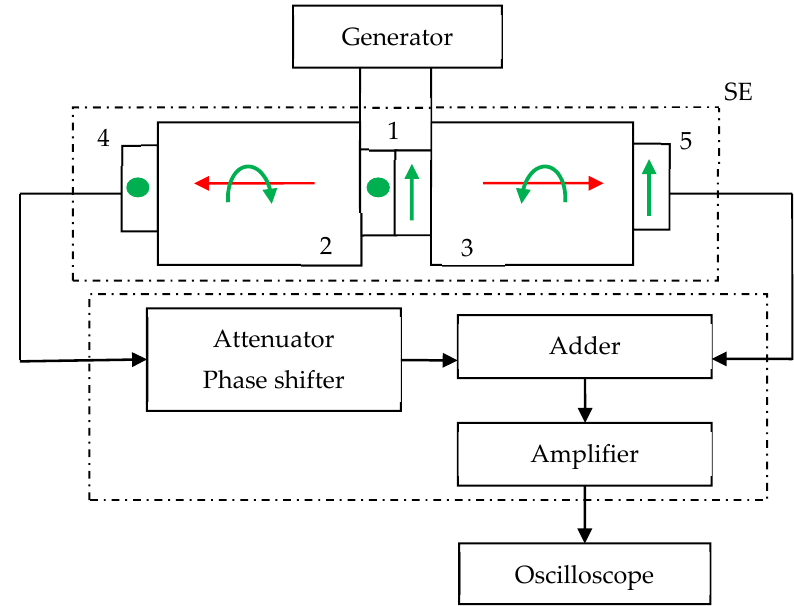
Figure 9. The scheme of the test model of the RRS SE on CPAW.